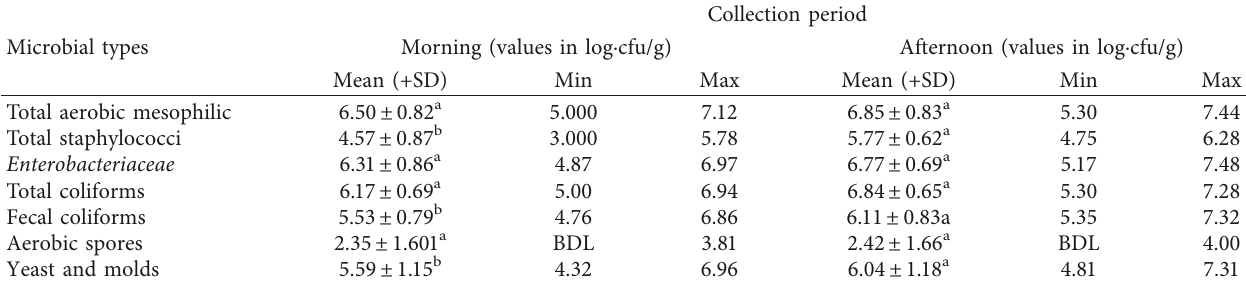
Table 2: Comparison of microbial counts (log · cfu/g) of minced meat samples collected from butcher shops. Microbial types